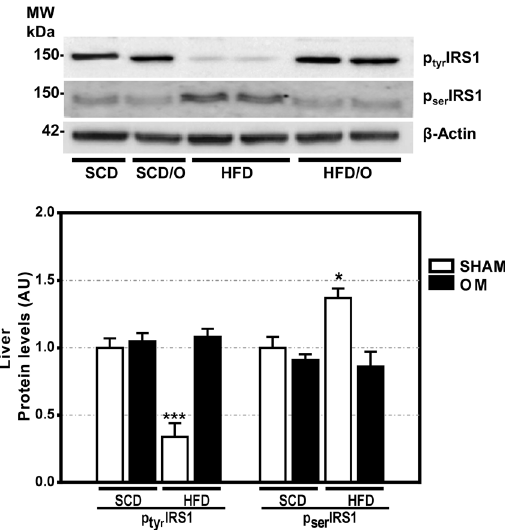
Figure 2. Effect of omentectomy on insulin resistance and leptin resistance, in rats fed a HFD. ( a ) Tyrosine and serine phosphorylation of IRS1 in the liver of rats fed a standard chow diet with omentectomy (SCD/O) and without it (SCD), and in rats on a high fat diet with omentectomy (HFD/O) and without it (HFD). Bar graph illustrating the protein expression of IRS1 is shown at the bottom of the figure. The protein expression in sham group fed a SCD was assumed to be 1. Results are given as mean ± S.D., * p < 0.05; *** p < 0.001 vs .